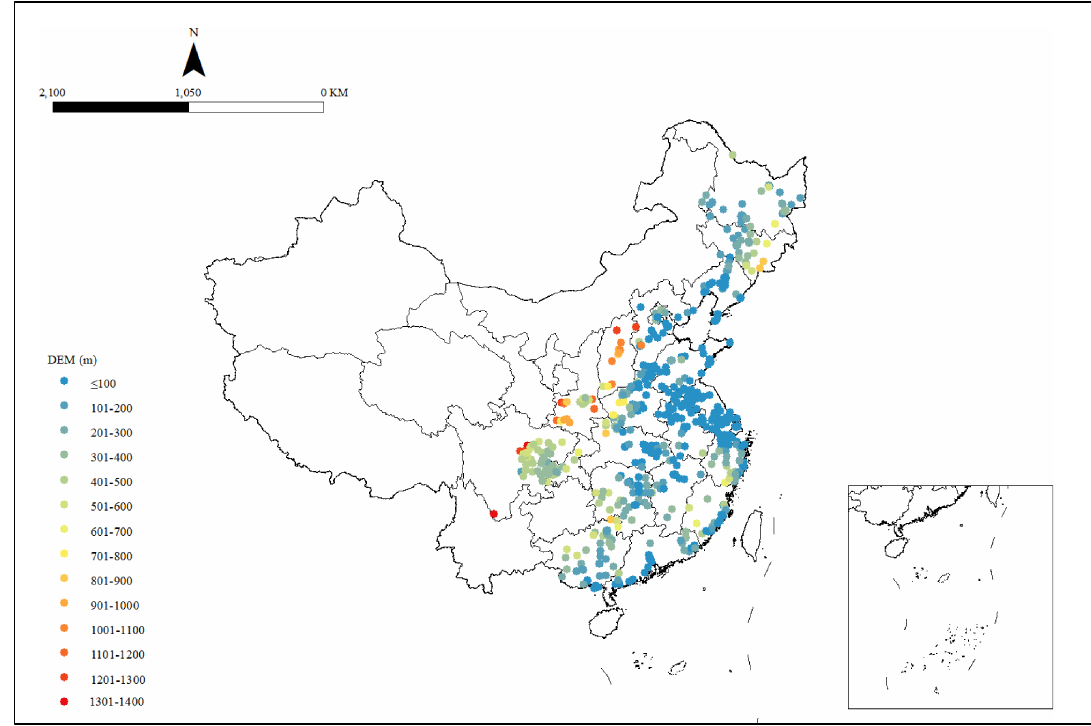
Fig. 2 Distribution of altitudes of the residential units assessed in the study.